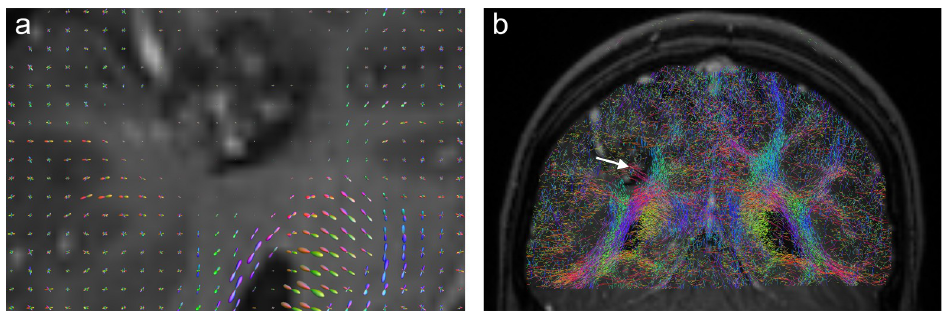
Fig 12. Coronal slices from patient B: (a) FODs and (b) results of probabilistic tractography with minimum FOD length = 0.025, showing erroneous fibers within the cavernoma (white arrow).